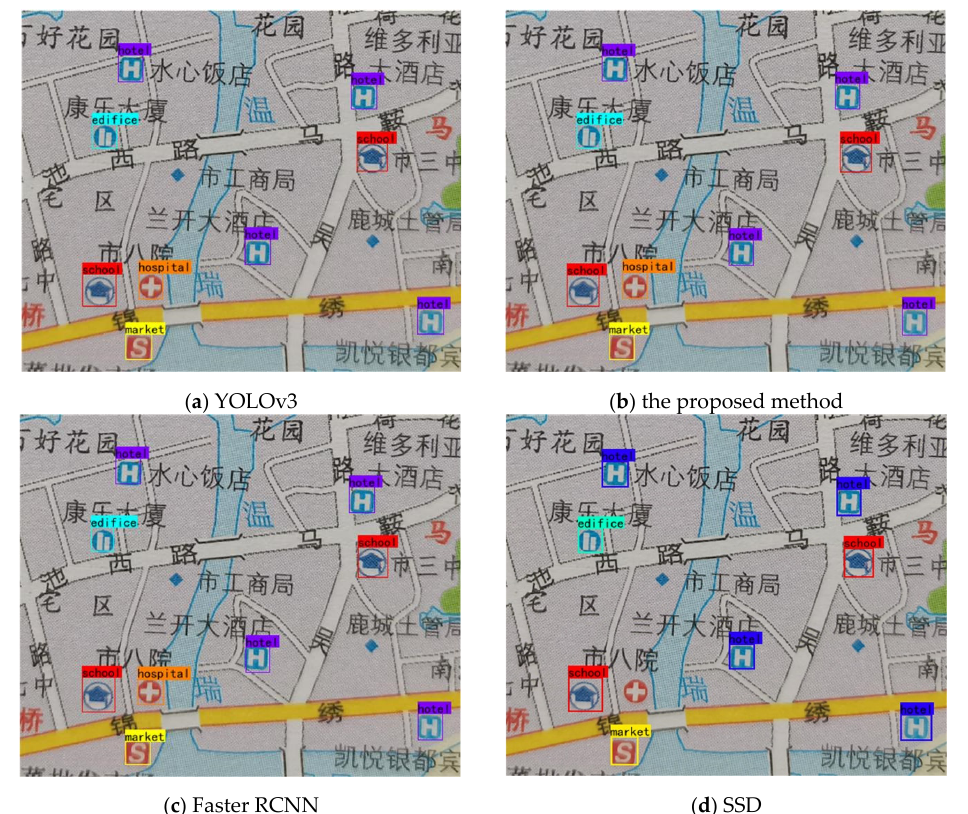
Figure 7. Point Symbols Recognition Results of Four Models on the Target Bigger Map: ( a – d ) are the recognition results of YOLOv3, the proposed method, Faster RCNN, and SSD on another style city map and a more prominent target map, respectively.